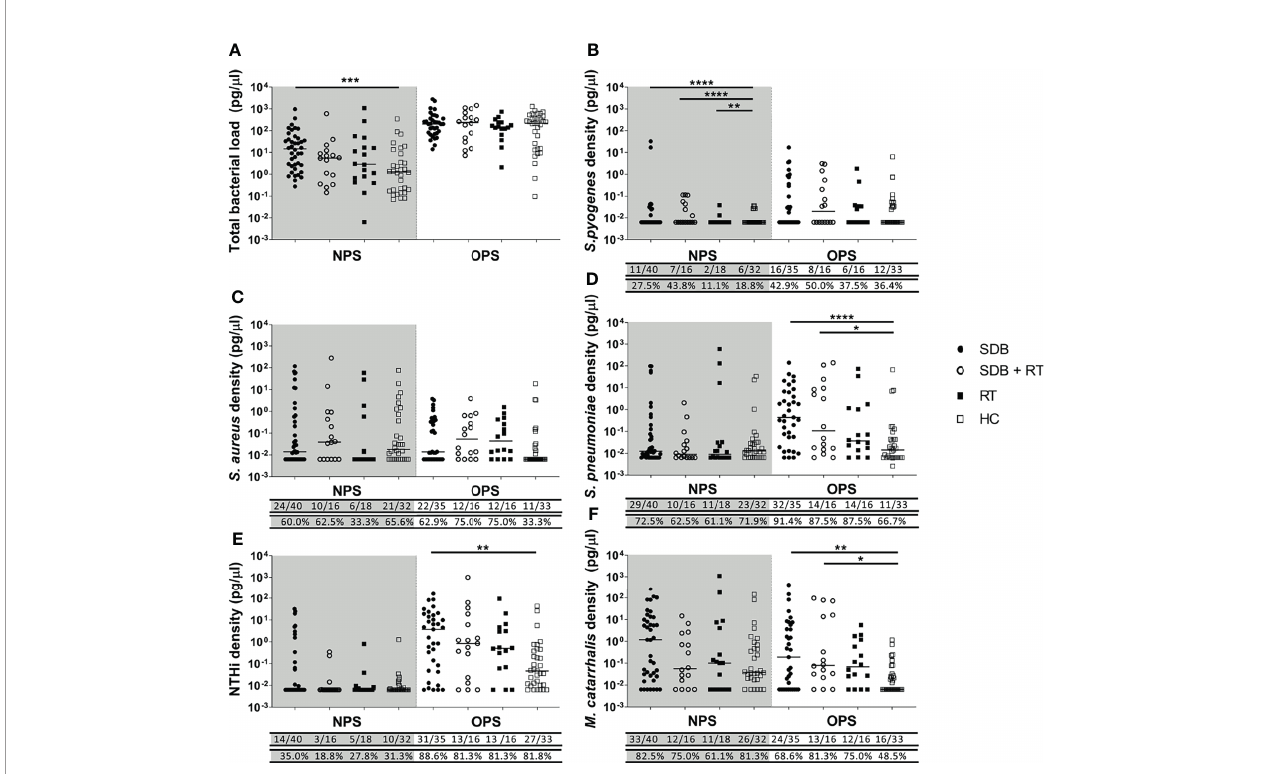
FIGURE 1 | Total bacterial load (A) and speci fi c bacterial density (B – F) in the nasopharyngeal swabs (NPS) and oropharyngeal swabs (OPS) from children with SDB ( (cid:129) ), SDB+RT ( ⚬ ), RT ( ▪ ) and healthy children (HC) ( ▫ ). p value * < 0.05; **< 0.01; *** < 0.001; **** < 0.0001. Numbers underneath each graph represent the proportion of children in each group considered positive for each bacterial species with numbers on the top row and the corresponding proportion in the bottom. Samples not available: 1 NPS from a child with SDB+RT and 1 NPS from a healthy child; 5 OPS from children with SDB, 1 OPS from a child with SDB+RT and 2 OPS from children with